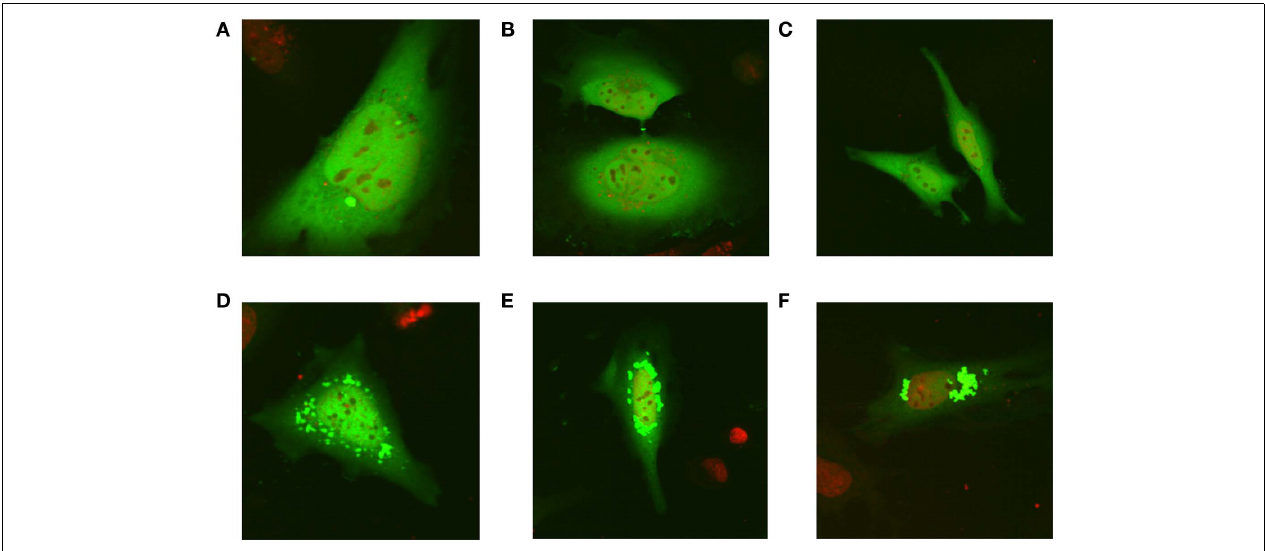
FIGURE 7 | MTHFS-GFP forms clusters in purine-depleted media. The MTHFS-GFP fusion protein was expressed in HeLa cells maintained in either purine-rich α MEM medium (A–C) or purine-depleted RPMI-1640 medium (D–F) as described in Section “Materials and methods.” Nuclear DNA stain in red (DRAQ5) and MTHFS-GFP is